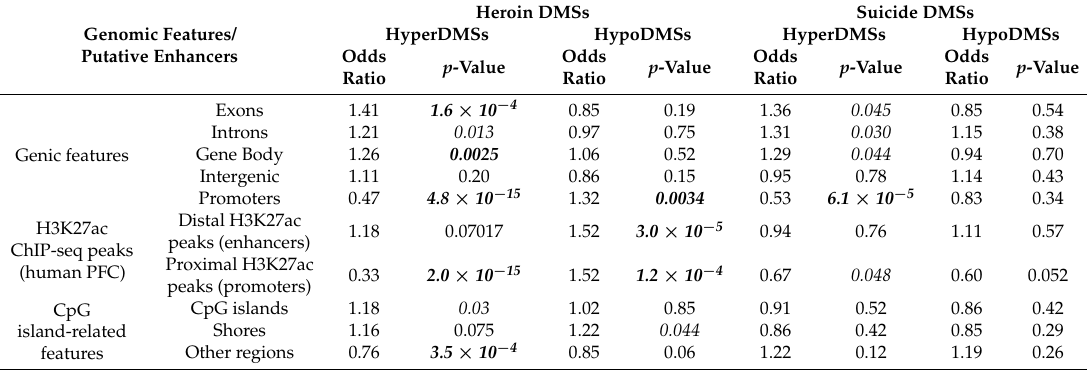
Table 1. Enrichment or depletion of hyper- and hypomethylated sites (DMSs) within genomic features and putative enhancers. Statistical significance was calculated by Fisher’s exact test. Promoters were defined as regions within − 1000 bp around the transcription start site. Significant ( p -value < 0.01) enrichments or depletions are shown in italic